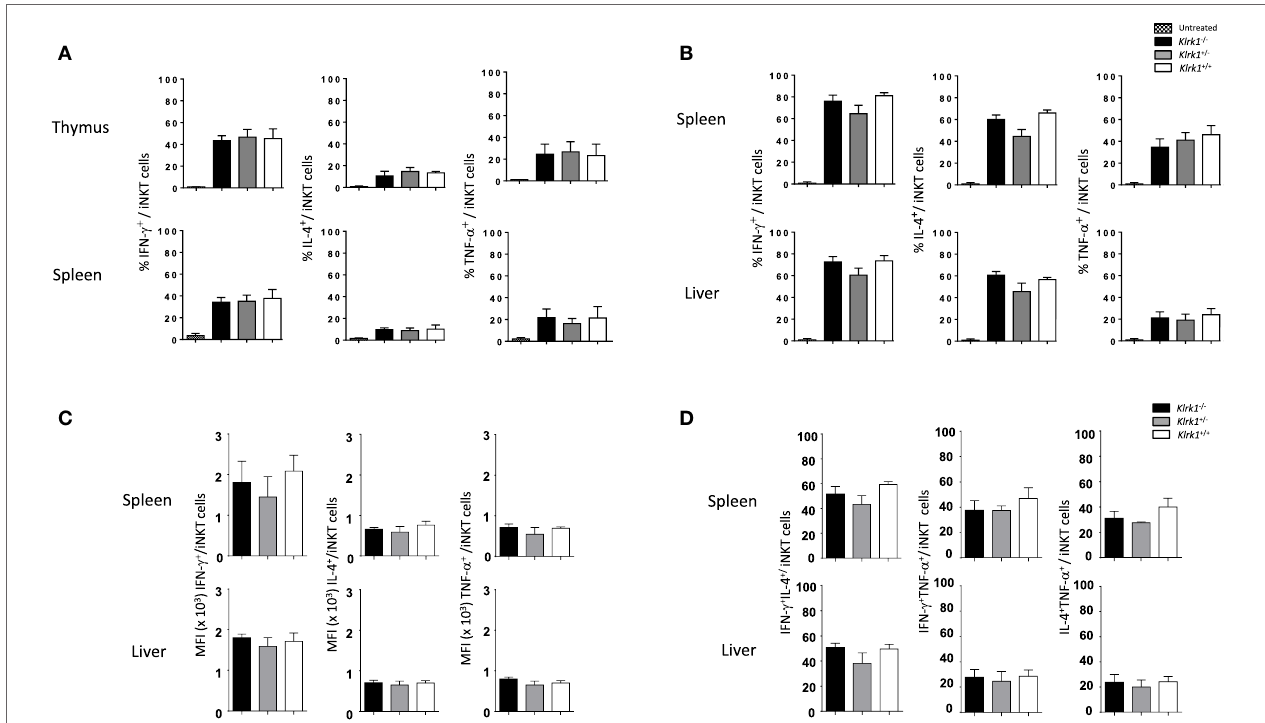
FigUre 3 | Unchanged cytokine production capabilities of invariant natural killer T cell (iNKT) cells in the absence of NK group 2 member D. (a) Frequencies of interferon (IFN)- γ , interleukin (IL)-4, and TNF- α production by iNKT cells in vitro, assessed by intracellular staining, in the thymus and spleen upon PMA/ionomycin stimulation for 4 h. (B) Frequencies of IFN- γ , IL-4, and TNF- α production by iNKT cells, assessed by intracellular staining, in the spleen and liver in vivo 2 h after i.p. injection of α -galactosylceramide. (c) Mean florescence intensity (MFI) of IFN- γ , IL-4, and TNF- α expression by iNKT cells from the experiment in (B) . (D) Frequencies of IFN- γ + IL-4 + , IFN- γ + TNF- α + , and IL-4 + TNF- α + producing iNKT cells from the experiment in (B) . iNKT cells are defined as tet + HSA low in the thymus or tet + B220 − in the spleen or liver. Data are from three experiments where three mice aged 5- to 6-week old were used per experiment and presented as mean ±